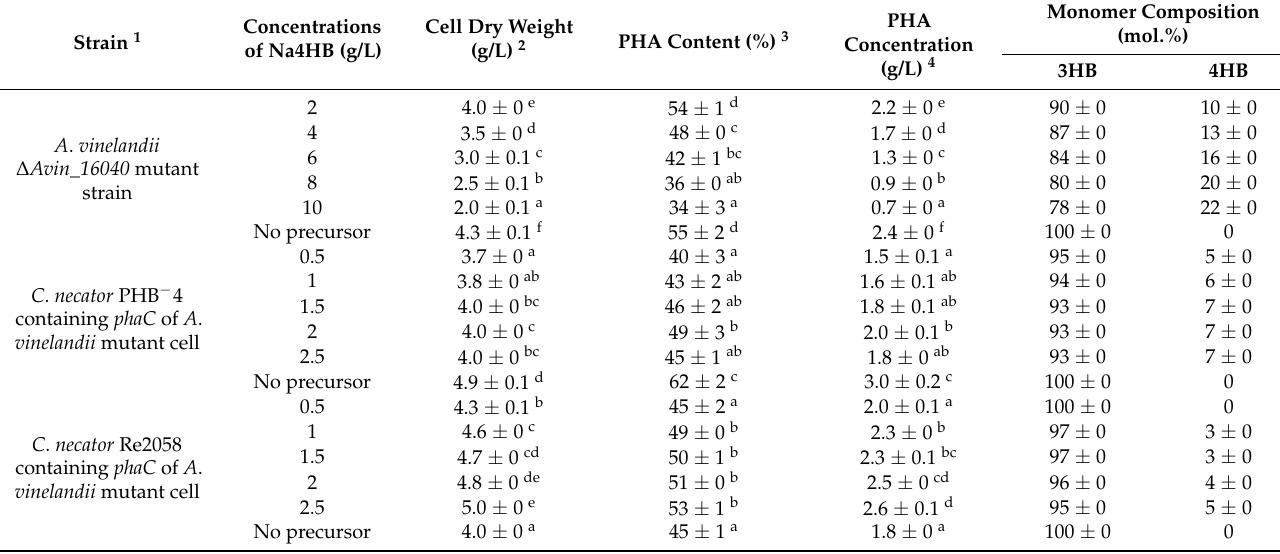
Data shown are means of triplicate. The superscripts represent the significant difference of the data using statistical analysis ( p < 0.05) for each bacterial strain. Superscript alphabets for each column that are different indicate a significant difference. 1 A . vinelandii ∆ Avin_16040 mutant strain and the transconjugants were cultivated using 30 g/L of fructose and 0.54 g/L of urea at 30 ◦ C with agitation speed of 200 rpm. A . vinelandii ∆ Avin_16040 mutant strain was cultivated for 72 h while the transconjugants were cultivated for 48 h. Different concentrations of Na4HB were used. ‘No precursor’ indicates no addition of precursor in the medium. 2 Cell dry weight was obtained after freeze-drying process. 3 PHA content of freeze-dried cell was determined using gas chromatography. 4 PHA concentration = cell dry weight * (PHA